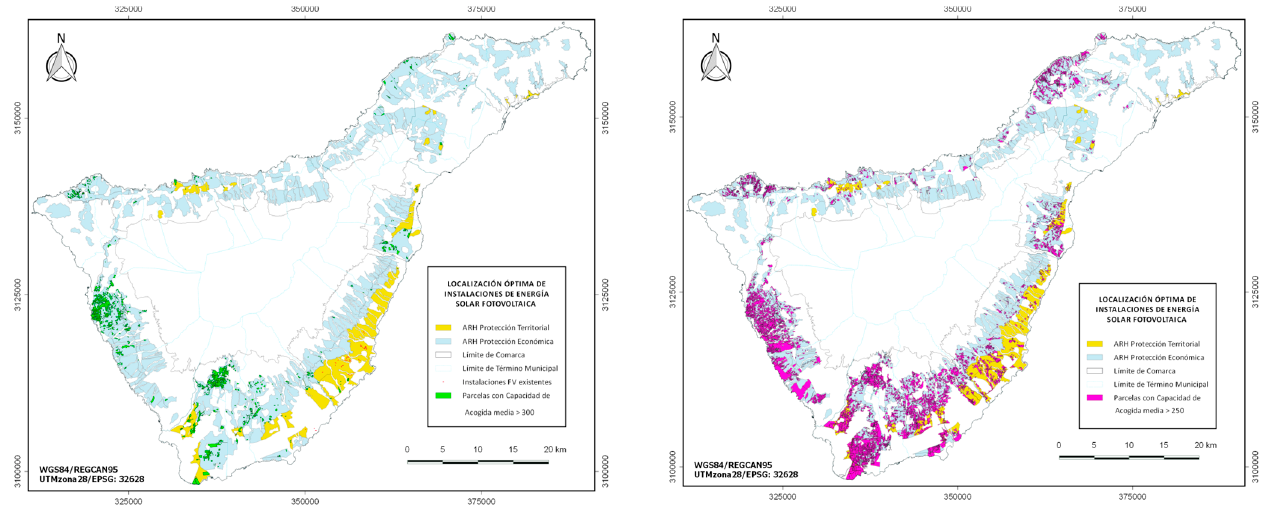
Figure 8. Optimal locations on the Tenerife island together with existing PV facilities: Plots with average RC > 300 ( left ) and Plots with average RC> 250 ( right ).